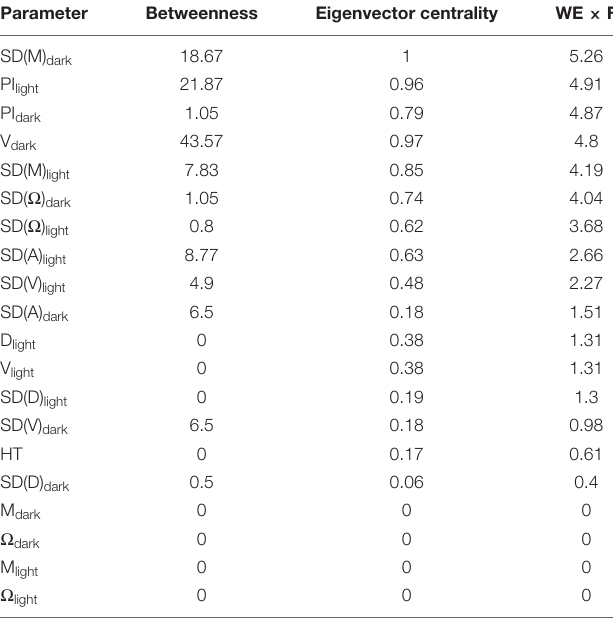
TABLE 1 | Measures of network centrality and influence for the swimming behaviour parameters during the light and dark phase of the light dark challenge assay: distance moved (D, mm), velocity (V mm s − 1 ), acceleration (A mm s − 2 ), meandering (M, ◦ mm − 1 ), angular velocity ( (cid:127) , ◦ s − 1 ), and percentage Immobility (PI, %), and the variation thereof in standard deviation